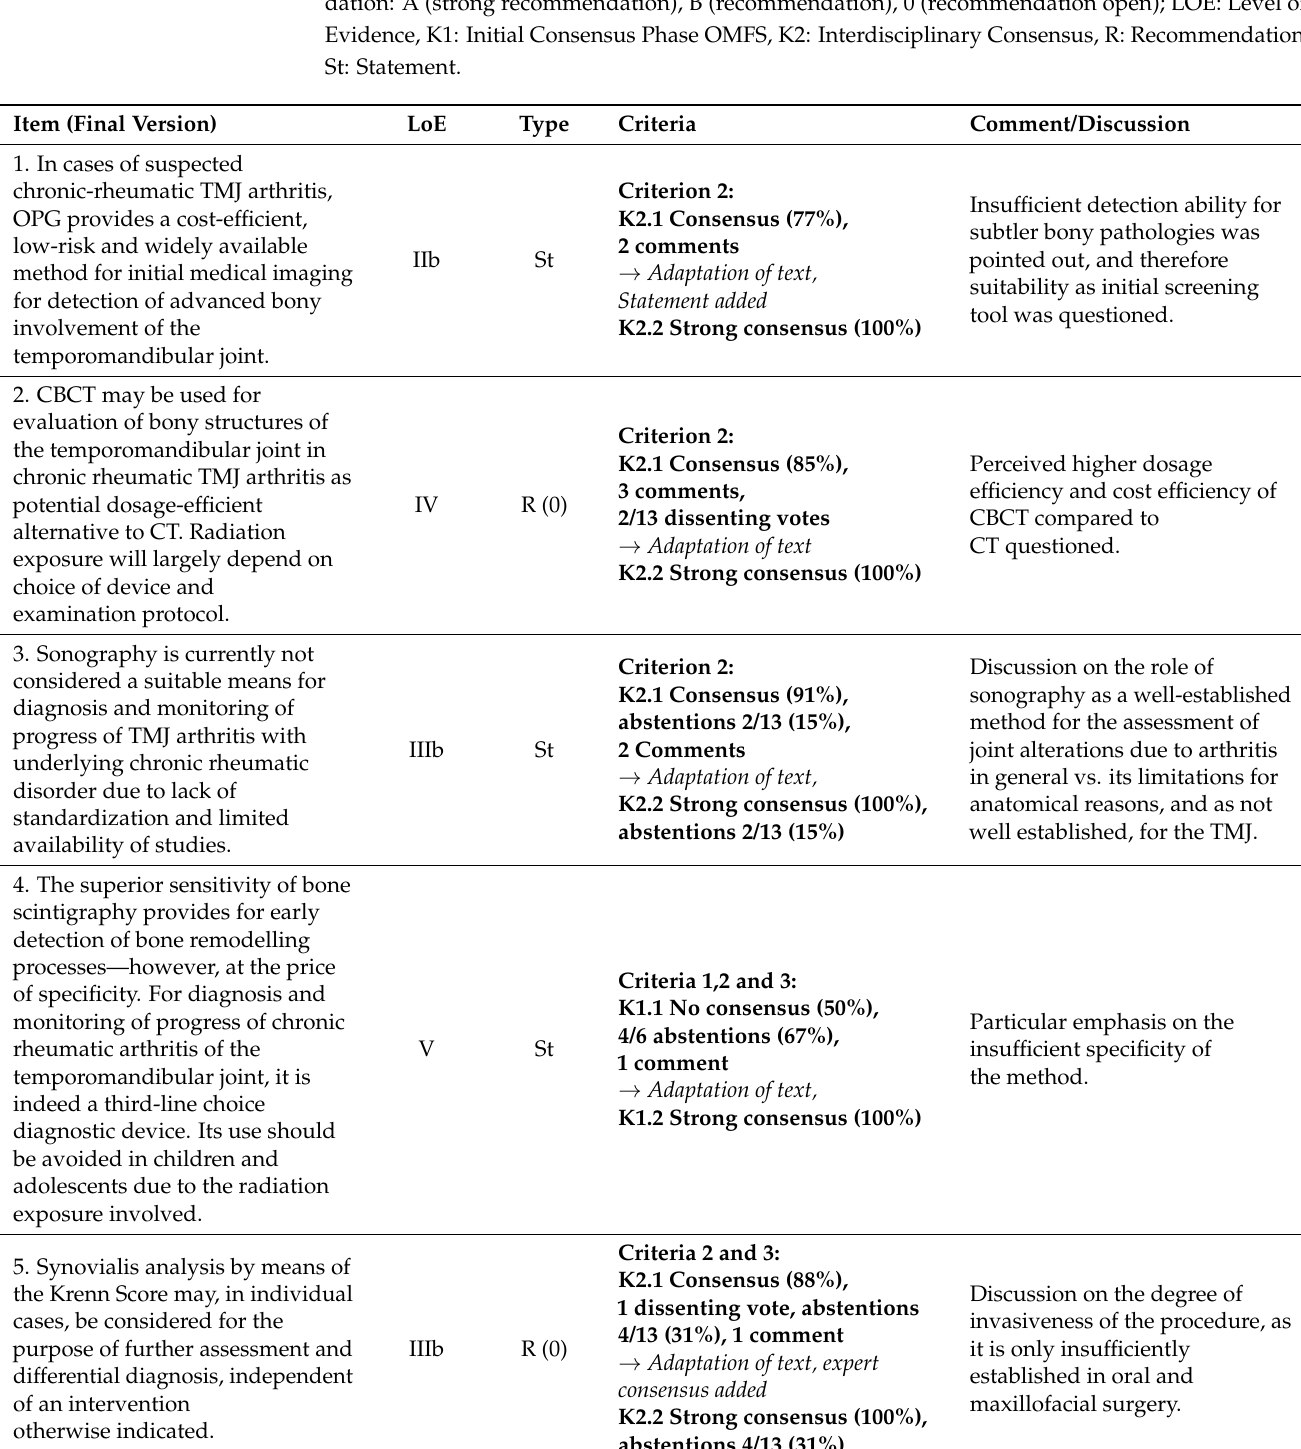
Table 11. Controversial recommendations and statements (legend: (A)/(B)/(0): Grade of